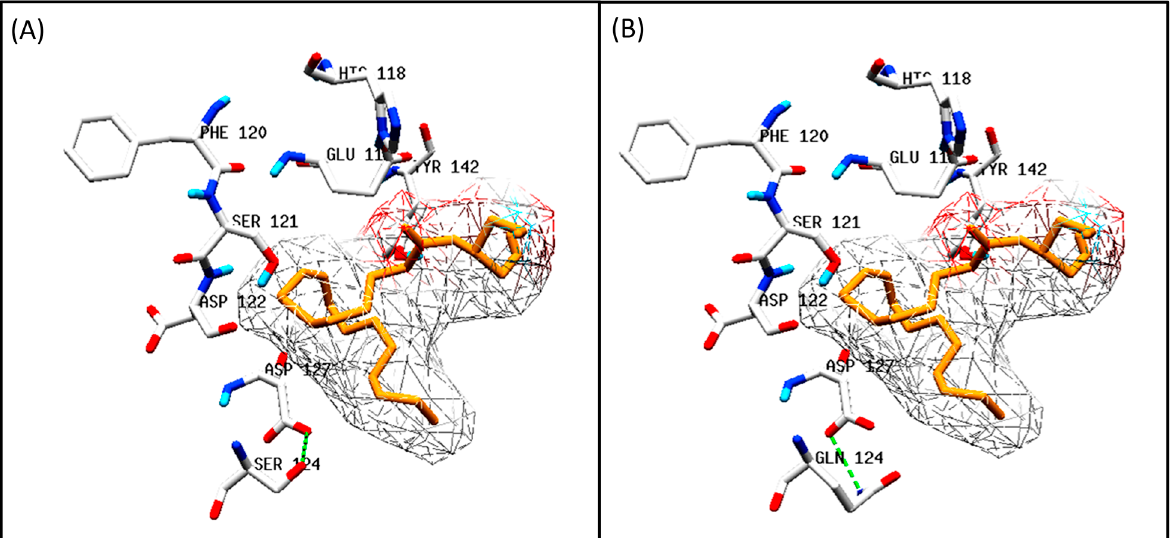
Figure 4. Molecular docking of oleoyl glycerol as the ligand and the predicted structure of EoFAD2 from Elaeis olifera as the receptor ( A ) and the other studied oilseed species ( B ) performed using AutoDock Vina v1.2.